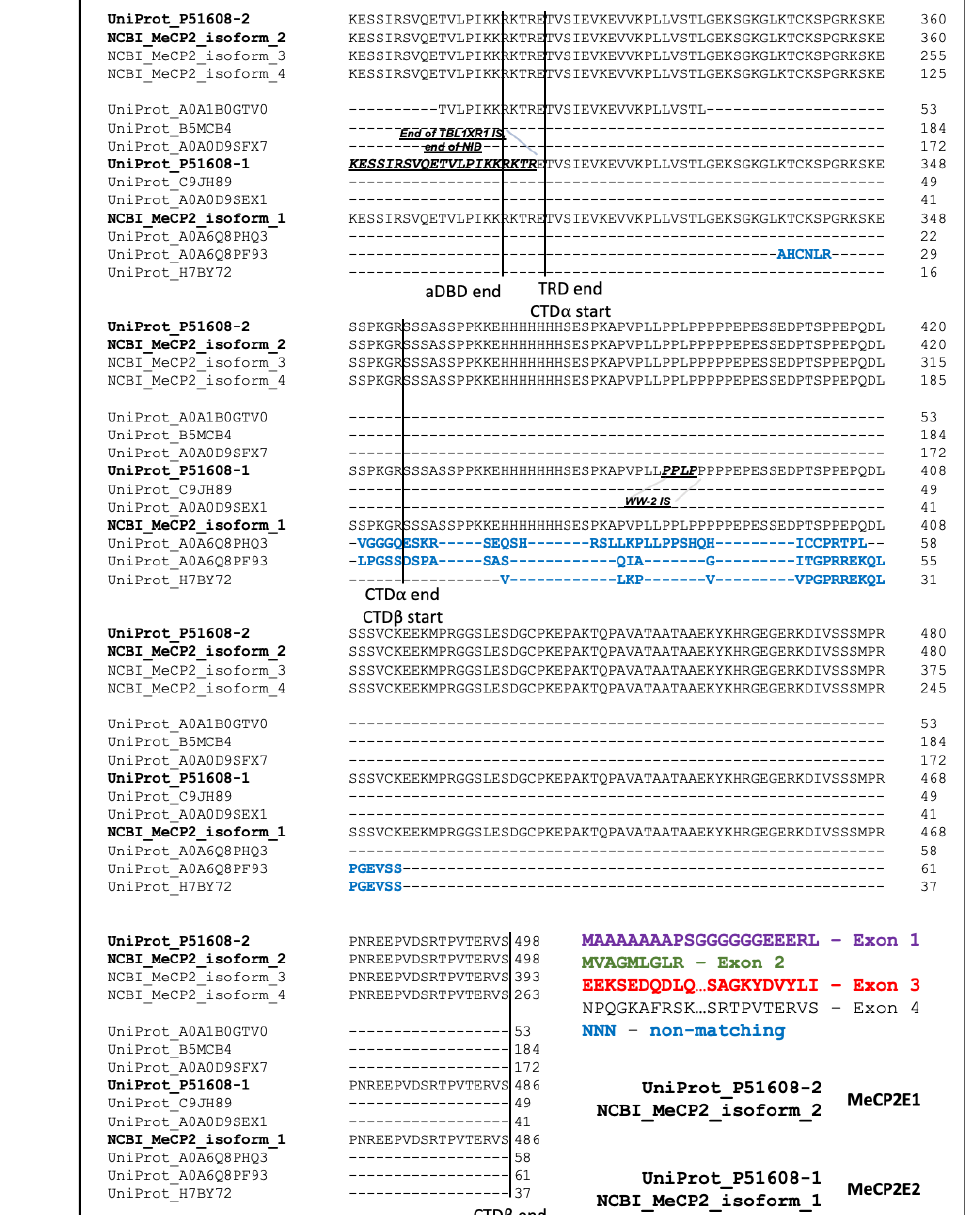
Figure 1. Alignment of potential MeCP2 protein isoforms from NCBI and UniProt. The sequences are in the N-terminal to C-terminal orientation. MeCP2E1 and MeCP2E2 from both NCBI and UniProt are shown in bold. The raw output from ClustalOmega was split into 2 panes and exons were colour-coded as indicated in the figure legend. Functional domains are labeled with start and end flags on MeCP2E2 (NCBI isoform 1 and UniProt P51608-1), while protein interaction sequences were underlined. The sequences of exons 1, 2, 3, and 4 were coloured purple, green, red and black respectively. Non-matching to either isoform sequences were coloured blue. aDBD: alternative DNA binding domain; CTD α : C-terminal domain α ; CTD β : C-terminal domain β ; HMGD1: high mobility group protein-like domain 1; HMGD2: high mobility group protein-like domain 2; MBD: methyl-CpG-binding domain; NID: NCoR/SMRT interaction domain; NLS1: nuclear localization signals 1; NLS2: nuclear localization signals 2; TBL1XR1 IS: TBL1XR1 interaction sequence; TRD: transcriptional repression domain; WW-2 IS: Group 2 WW motif-containing protein interaction sequence. References and amino acid numbers of each feature were summarized in Supplementary Table S1.